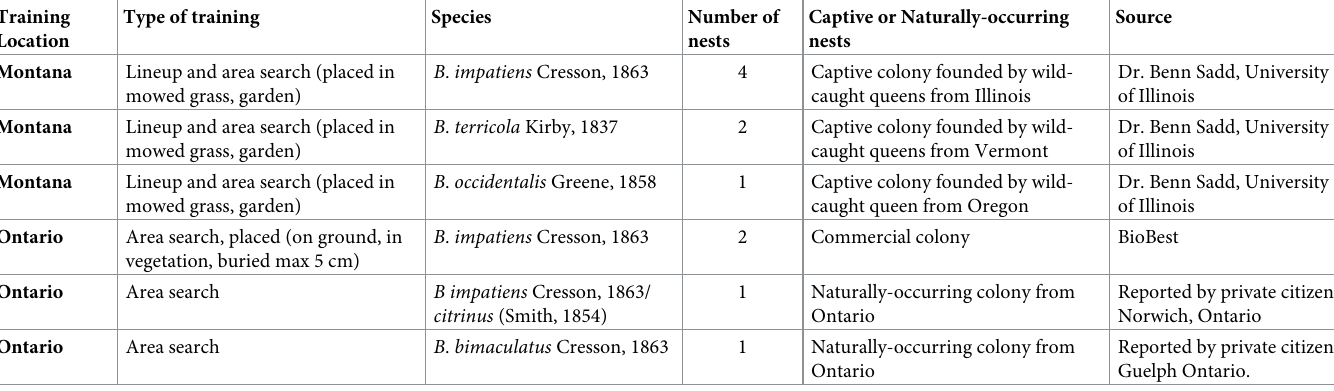
Table 1. A description of the training bumble bee nest samples the dogs were exposed to in Montana, USA and Ontario, Canada. Training